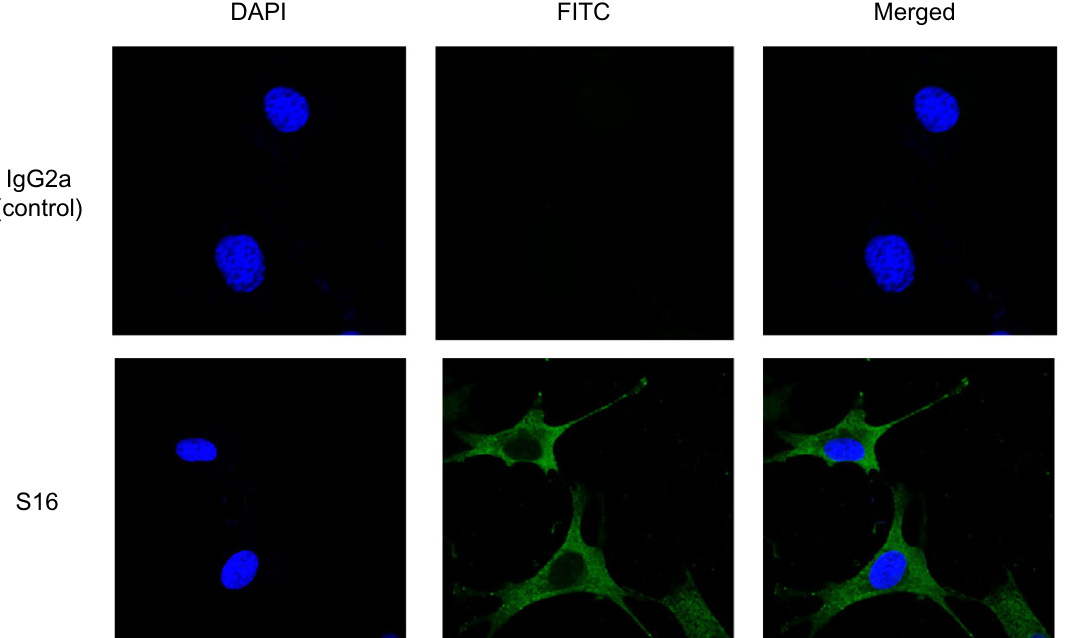
Figure 1. Immunofluorescence images of mouse NIH3T3 cells stained for S16. Uninfected mouse NIH3T3 cells were fixed with 4% paraformaldehyde and permeabilized with cold methanol. An immunofluorescence assay was performed using FITC-conjugated IgG2a isotype control (upper panels) or FITC-conjugated S16 (lower panels). The cells were observed for DAPI (left panels) or FITC (middle panels). The merged images are shown (right